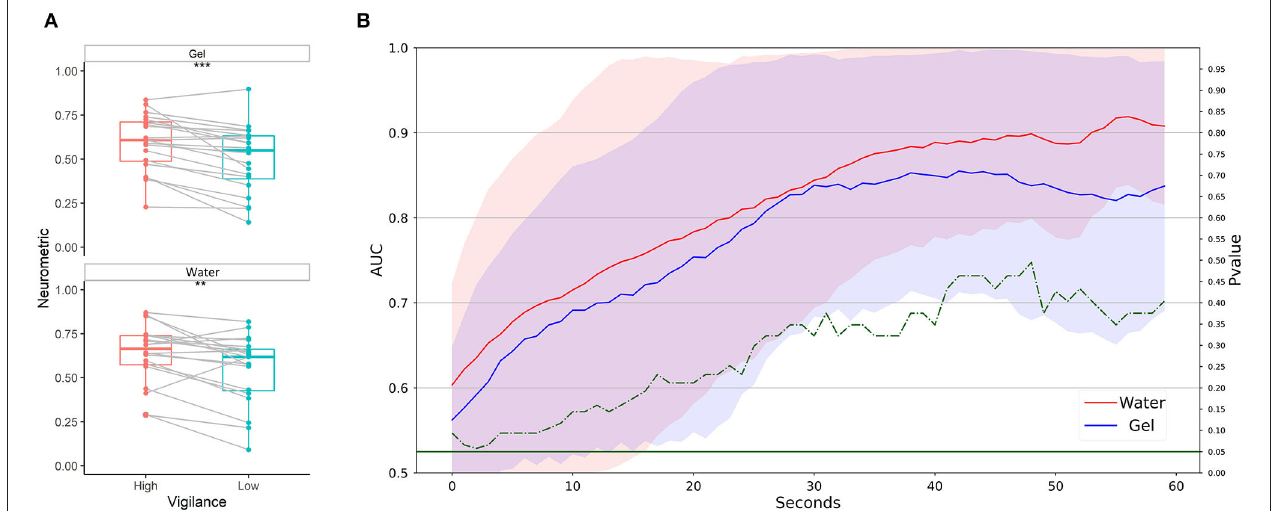
FIGURE 13 | Vigilance discrimination between low and high conditions in realistic settings. (A) Statistical comparison has been performed for water-based and gel-based Neurometrics. The asterisks show the results of the Wilcoxon signed-rank test (** p < 0.01, *** p < 0.001). (B) AUC values obtained by water (in red) and gel (in blue) electrodes for different time resolutions (1–60s). The solid lines represent the median of the AUC among the participants. The shadows represent the mean absolute deviation of the AUC across participants. The dashed green line represents the results in terms of p -values of the Wilcoxon signed-rank test. The threshold of significance ( p = 0.05) has been highlighted in the same